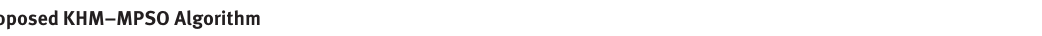
Table 5: Obtained Results for the Proposed KHM–MPSO Clustering on Eight Real Data Sets for p = 2.5, p = 3, and p = 3.5 Based on KHM( X , C ), F -Measure, and Runtimes (for 100 Independent